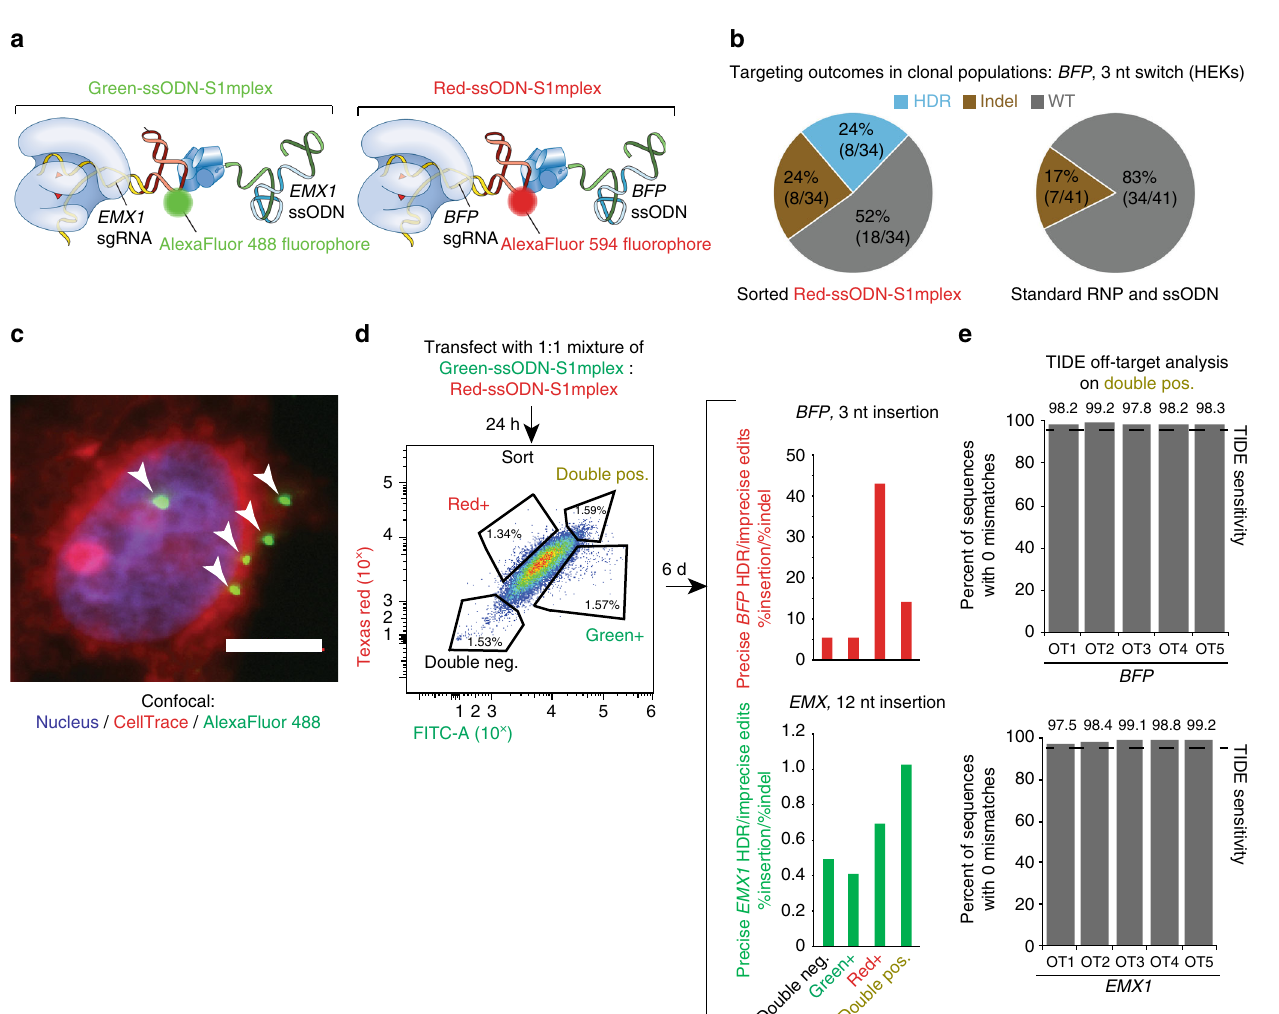
Fig. 6 Fluorescent S1mplexes to enrich for gene-edited cells. a Schematic of simultaneous editing at two loci strategy. HEK cells were transfected simultaneously with two S1mplex particles, labeled with distinct fl uorophores. Editing at BFP locus was associated with Red-ssODN-S1mplexes (AlexaFluor- 594 fl uorophore), while editing at EMX1 locus was associated with Green-ssODN-S1mplexes (AlexaFluor-488 fl uorophore). b Single cell sorting for enrichment of editing at BFP locus. In enriched S1mplex clonal populations, indels (brown) and HDR (blue) events occurred in a 1:1 ratio. In sgRNA clones, all isolated clones either had indel or wild-type genotypes. Genotypes were assayed by Sanger sequencing. No mosaic genotypes were observed. c Fluorescent S1mplexes inside the cell using confocal microscopy. Arrows denote Green-S1mplex both inside the nucleus and outside the cell (scale bar: 10 µ m). d Twenty-four hours post transfection, cells were sorted into populations that were positive for either fl uorophore, both or neither. Analysis via deep sequencing was done 6 days post sorting. Top: ratio of precise (perfect sequence match to ssODN) to imprecise editing (indels) in sorted populations. Populations enriched for BFP targeted S1mplexes (red positive and double positive) had elevated ratios up to 40 times as many insertions as indels. Bottom: ratio of precise to imprecise editing in sorted populations. Populations enriched for EMX1 targeted S1mplexes (red positive and double positive) had elevated ratios of precise insertions to indels. See also Supplementary Table 9. e Off-target analysis of double-positive populations using TIDE at the top fi ve off-target locations for each sgRNA. No modi fi cations were detected below the TIDE limit of detection (dotted S1mplex (Fig. 6a). The two ssODN-S1mplexes were mixed and